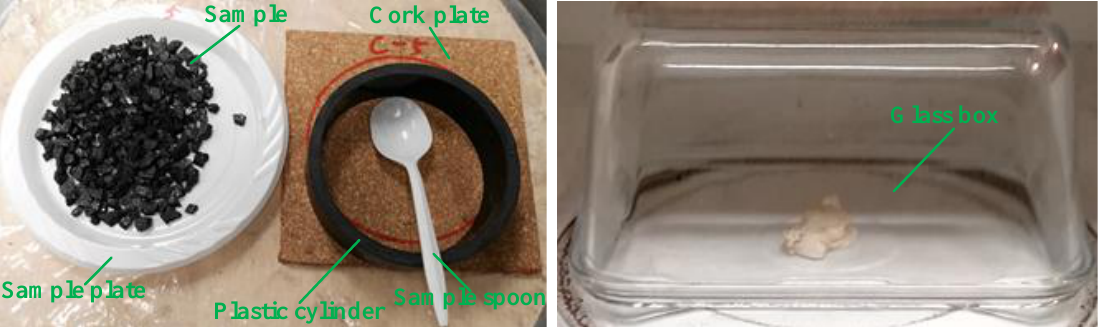
Figure 13. Accessories for microwave irradiation test.